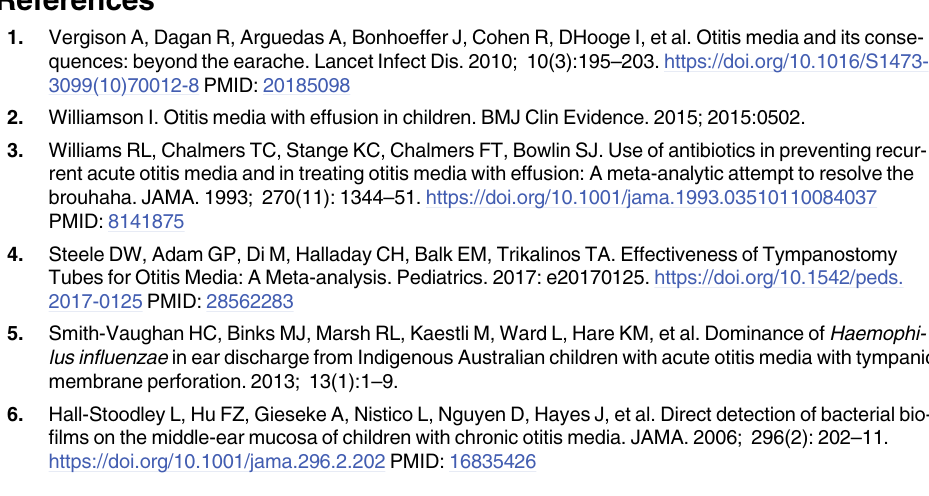
S4 Table. Genes down-regulated in H . influenzae 86 following 2 h growth in triple-species co-culture with S . pneumoniae 11 and M . catarrhalis